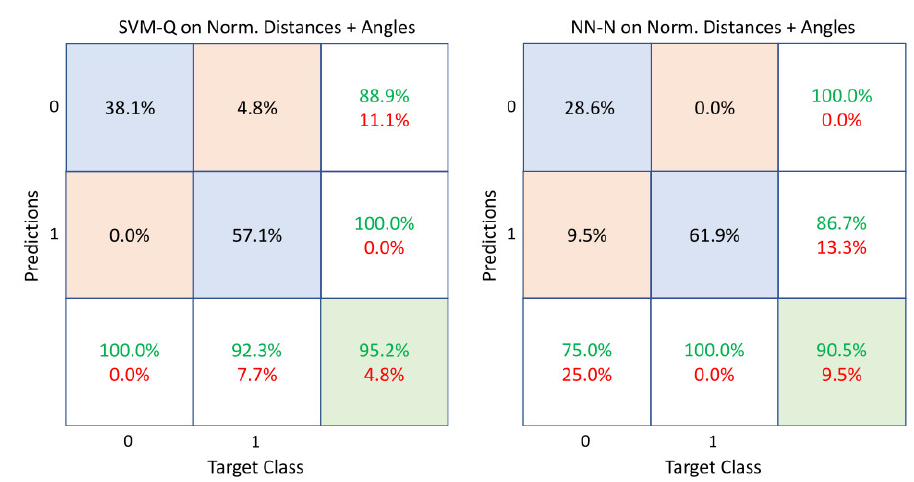
Figure 8. Confusion matrices of SVM-Q and NN-N when the combination of normalized distances and angles was used as a feature vector. The diagonal cells show the correctly classified observations (accuracies), whereas the off-diagonal cells show the incorrectly classified ones. The far-right column of each matrix shows the precision or positive predictive value (green) and the false discovery rate (red). The bottom row shows the sensitivity or true positive rate (green) and the false negative rate (red). Class 0 and class 1 represent healthy subjects and sick patients,